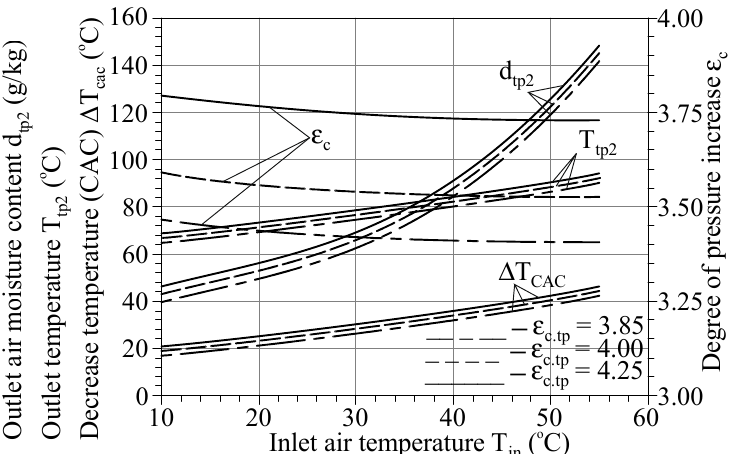
Figure 19. Dependences of the air moisture content at the thermopressor outlet, d tp2 ; air temperature at the thermopressor outlet, T tp2 ; decrease in the additional CAC air temperature, Δ T cac ; degree of pressure increase, ε c ’, at different total pressure increase, ε c . tp , on the inlet air temperature, T in .